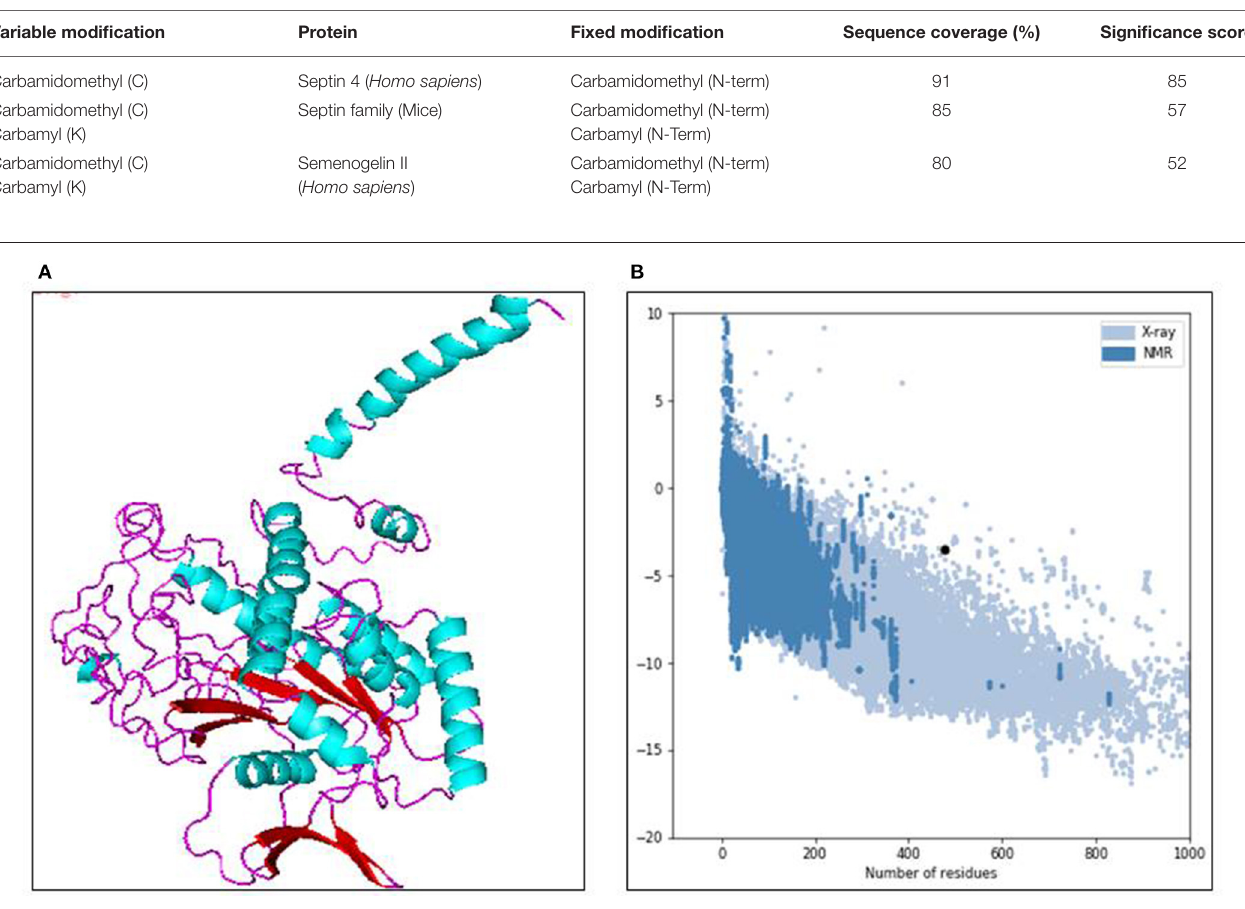
FIGURE 2 | (A) 3D structure model of human septin 4 visualized in PyMOL. (B) Protein quality check from ProSA